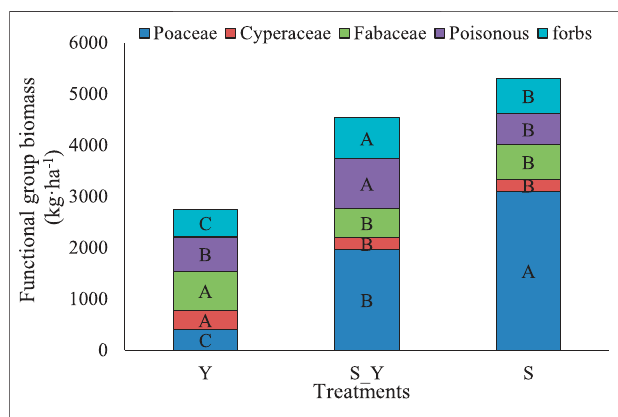
FIGURE 2 | Biomass of alpine meadow functional group according to grazing methods in